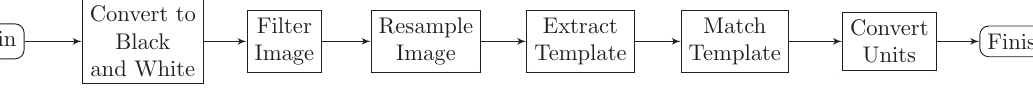
Figure 15. Overview of visual odometry